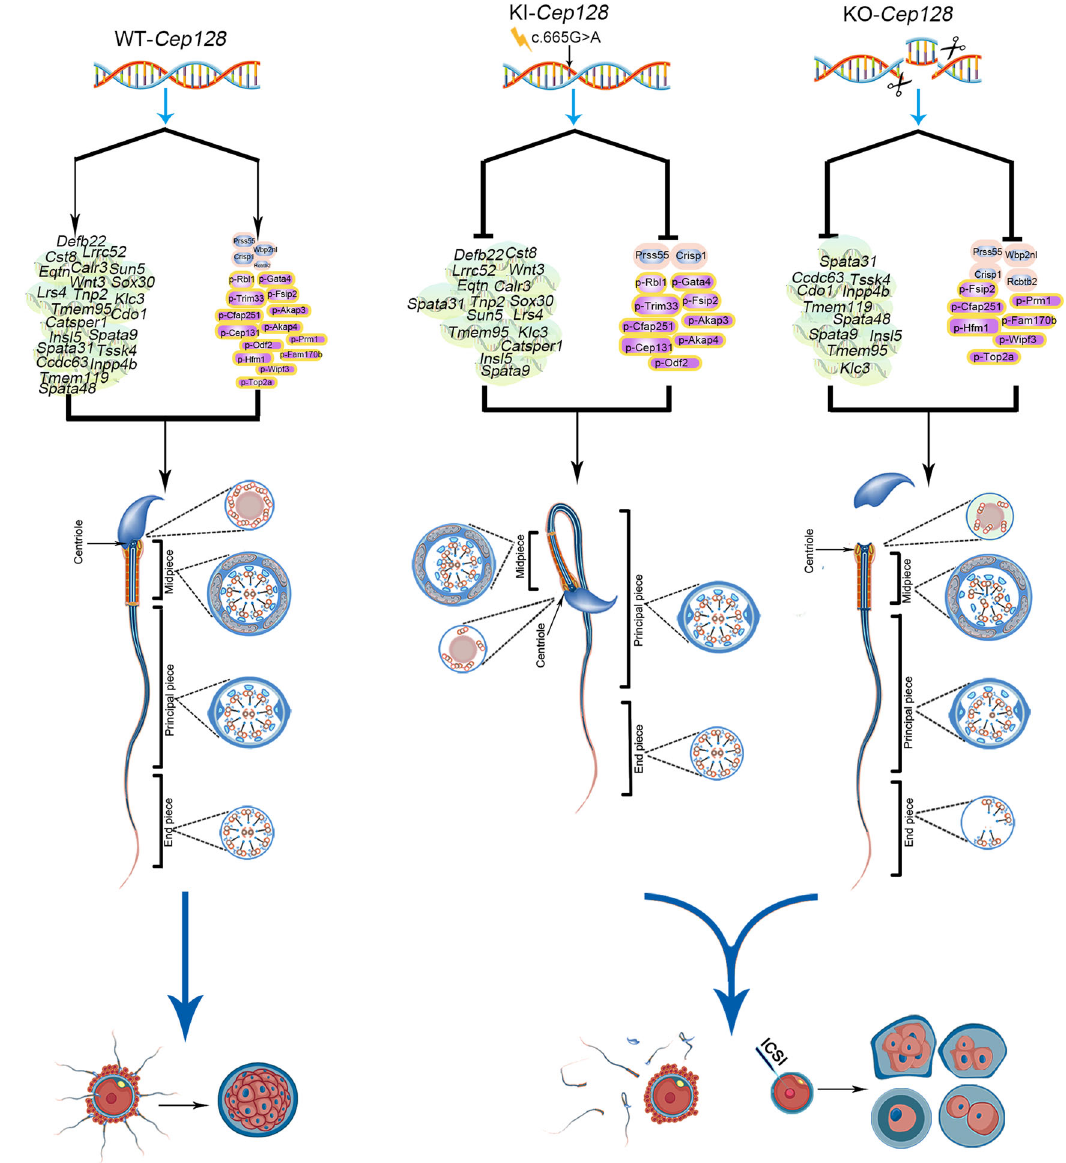
Fig. 9 Proposed model of CEP128 modulation of male reproduction. The imbalance observed in CEP128 levels included increased CEP128 abundance or loss of CEP128 protein, which suppressed the normal functioning of genes/proteins essential for sperm production and morphology as well as fertilizing capability. Normal sperm eventually failed to form, impairing typical reproductive